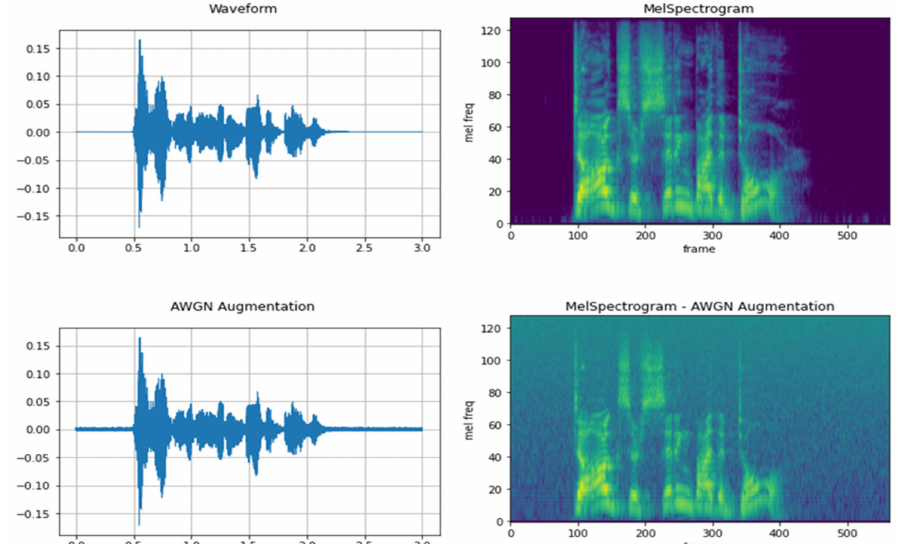
Figure 2. Comparison of the original audio signal’s waveform and mel-spectrogram compared with an Additive White Gaussian Noise augmented signal.